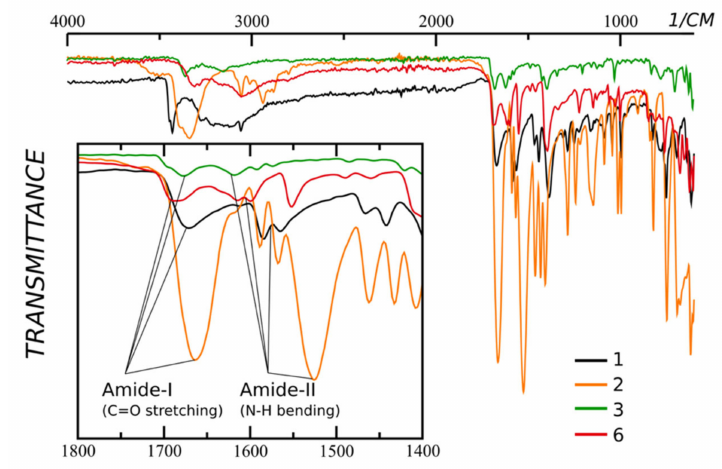
Figure 1. IR-spectra of compounds 1 ( ortho ), 2 ( ortho ) and 3 ( meta ), and 6 ( para ) pyridine carboxamides. The inset shows the zoomed 1800–1400 region. Note that the amide-II peak of ortho derivative 1 and para derivative 6 are overlaid with two peaks of C=C bending.